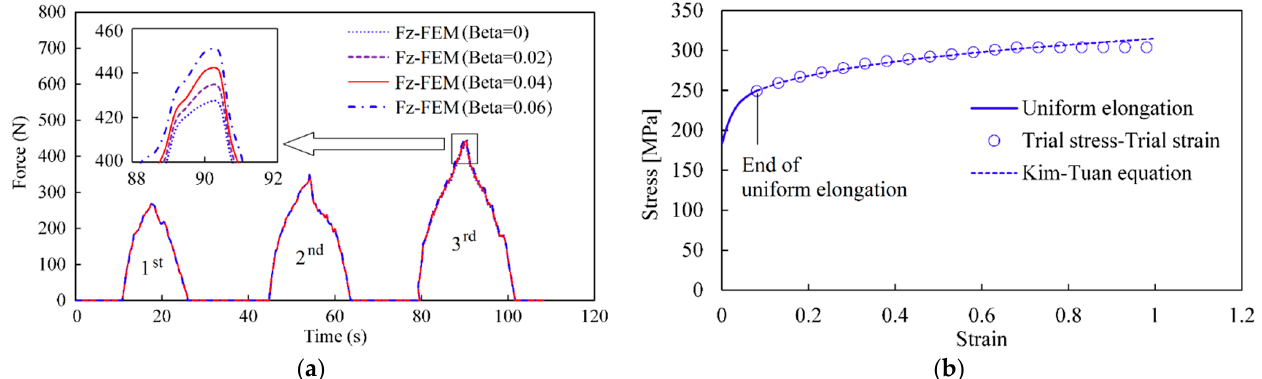
Figure 9. ( a ) Force prediction for the first three forming steps with the increment strain of (𝜀 (cid:3048) + 0.05) . ( b ) Best-fitted trial stress–trial strain in large strain range. ( b ) Best-fitted trial stress–trial strain in large strain